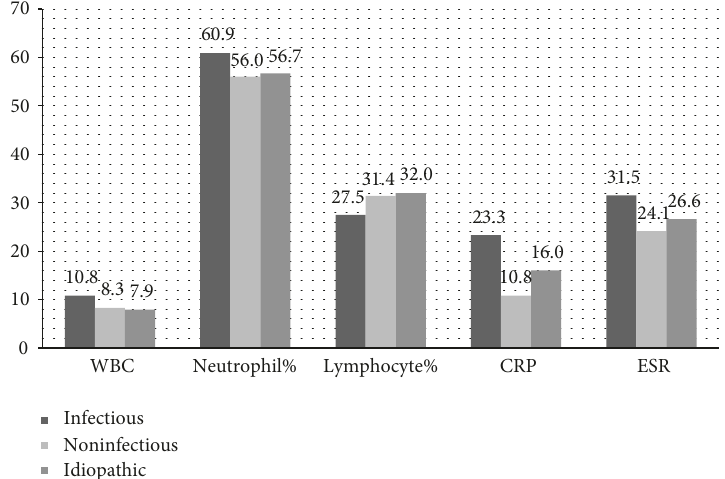
Figure 1: Laboratory parameters associated with infectious processes in erythema nodosum patients according to the etiological classi fi cation ( n = 81 ). WBC: white blood cell; CRP: C-reactive protein; ESR: erythrocyte sedimentation